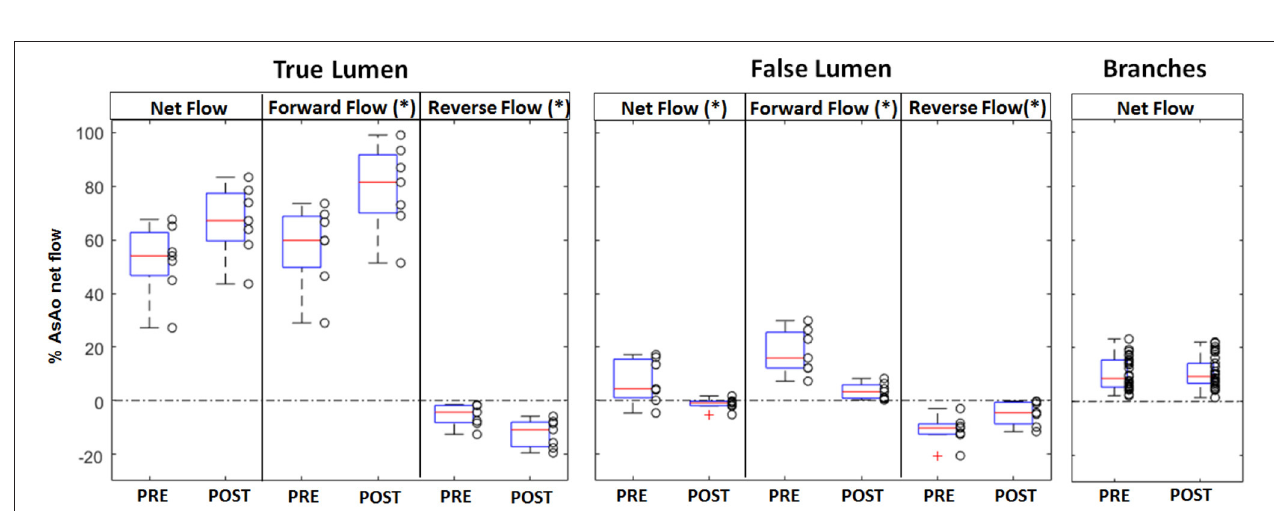
FIGURE 4 | Box plot representation of the net, forward, and reverse flows in the true and the false lumen, and the net flow in the aortic branches, measured pre and post-intervention. The box plot shows the first and third quartiles, the red line shows the median, and the whiskers show the minimum and respectively maximum value; outliers are shown as red crosses. For the aorta, each value represents the average flow along the vessel centerline between the left subclavian artery and the celiac trunk and is normalized to the net flow of the ascending aorta. Significantly different flow values were obtained post-operatively in the false lumen for net, forward, and reverse flow, and in the true lumen for forward and reverse flow (* indicates p < 0.05).